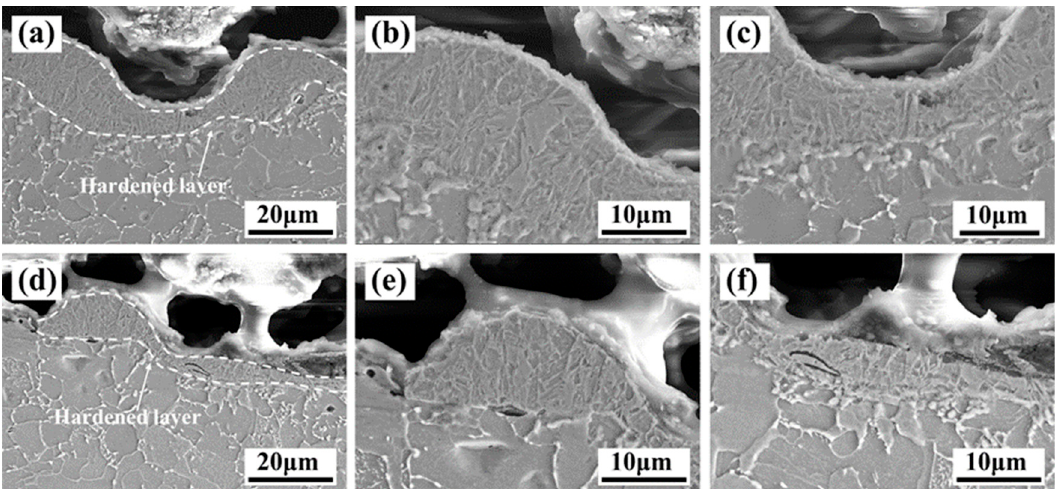
Figure 14. SEM image of the microstructure of the cross-section of the cleaned Q345 steel at a Y-moving speed of 7 mm/s and different X-scanning speeds after laser cleaning. ( a ) microstructure at speed of 7 mm / s and di ff erent X-scanning speeds after laser cleaning. ( a ) microstructure at 500 mm / s; 500 mm/s; ( b ) enlarged microstructure of the peak at 500 mm/s; ( c ) enlarged microstructure of the ( b ) enlarged microstructure of the peak at 500 mm / s; ( c ) enlarged microstructure of the valley at valley at 500 mm/s. ( d ) microstructure at 1000 mm/s; ( e ) enlarged microstructure of the peak at 1000 500 mm / s. ( d ) microstructure at 1000 mm / s; ( e ) enlarged microstructure of the peak at 1000 mm / s; mm/s; ( f ) enlarged microstructure of the valley at 1000 mm/s. ( f ) enlarged microstructure of the valley at 1000 mm /